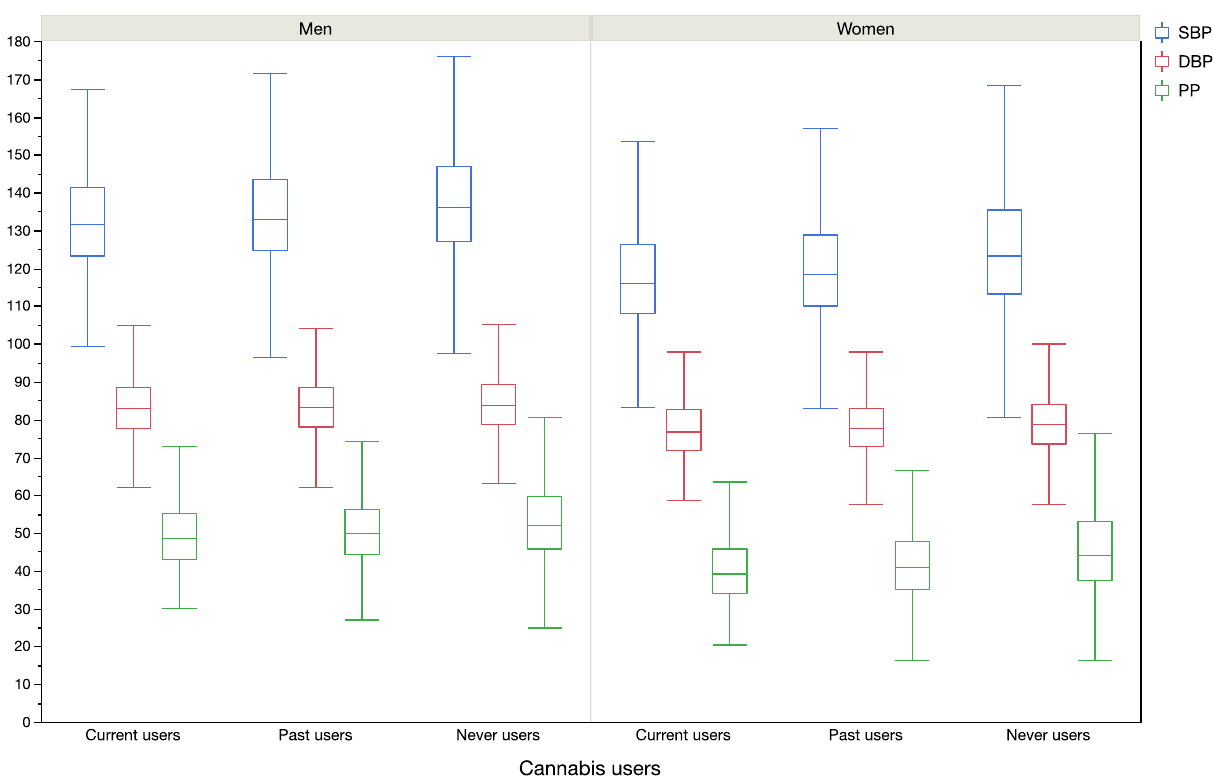
Figure 3. Blood pressure parameters (SBP, DBP and PP) according to gender and cannabis use groups (p < 0.001 in all subgroups).